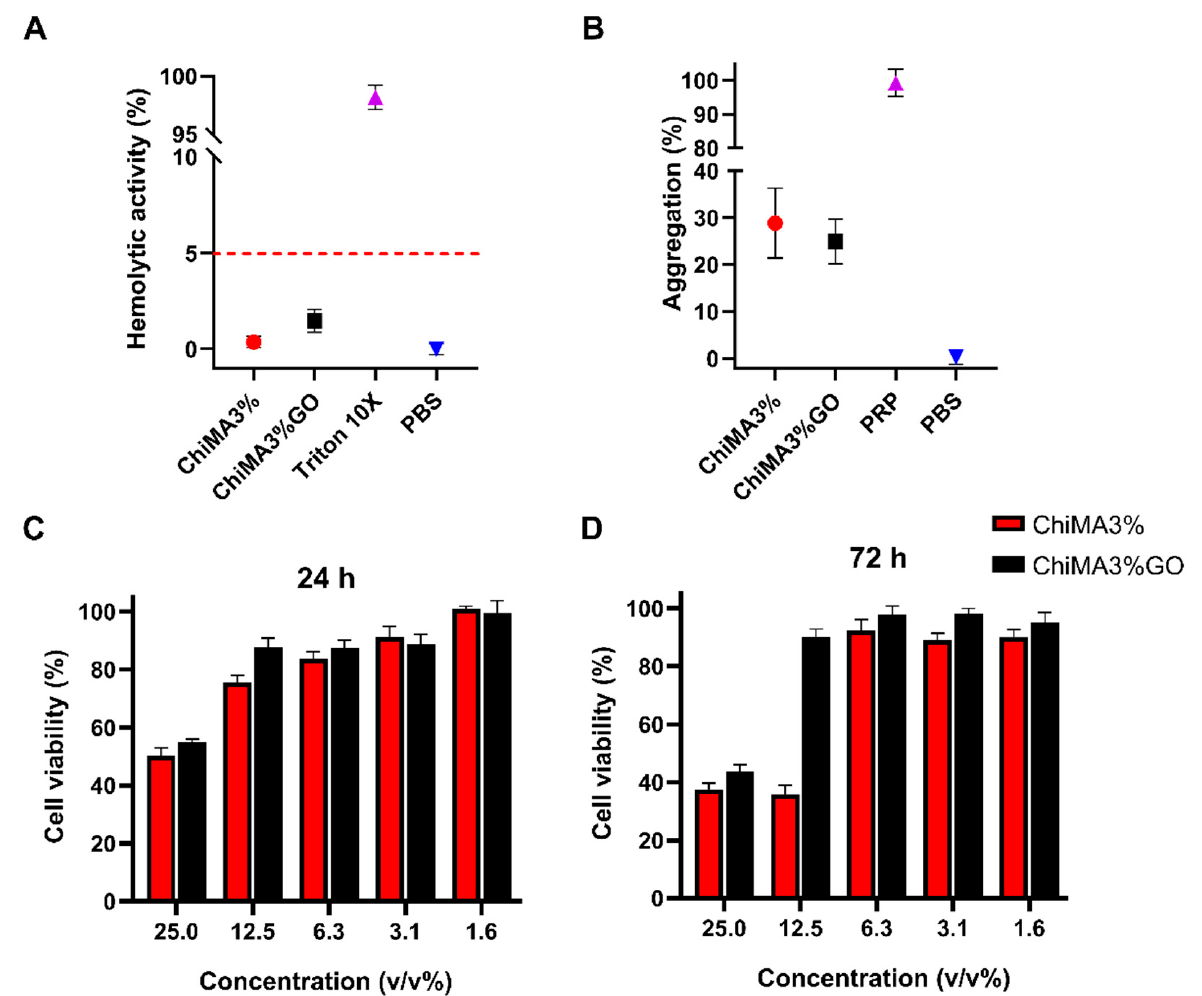
Figure 9. Biocompatibility evaluation of the ChiMA3% and ChiMA3%GO hydrogels. ( A ) Hemolytic activity and ( B ) platelet aggregation of the adhesive hydrogels. Cell viability of NHOst cells when exposed to the hydrogels for ( C ) 24 h and ( D ) 72 h.